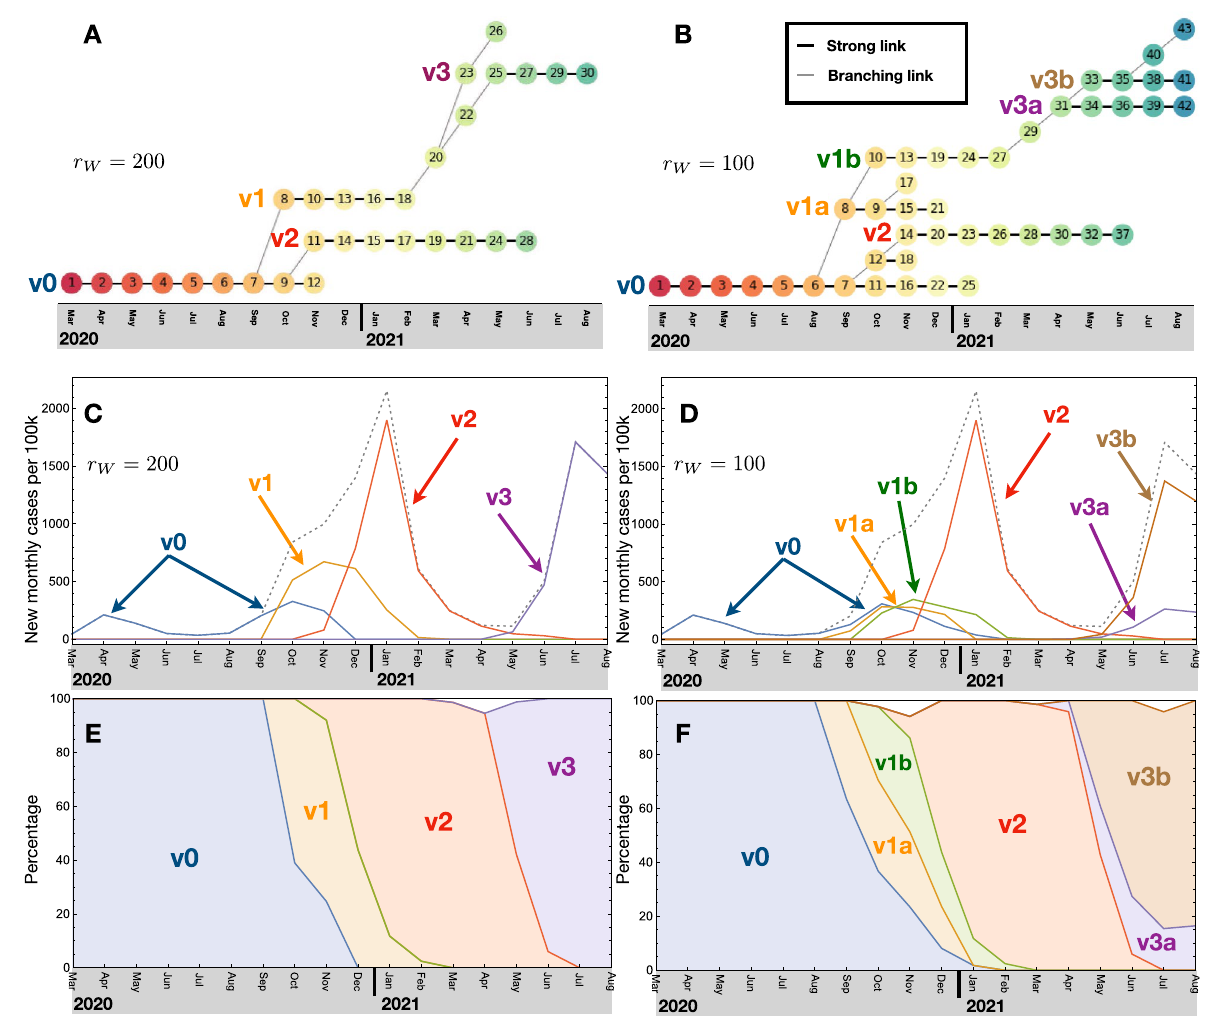
Figure 2. Monthly ML analysis and chain variants. The clusters are linked to form chains, which are then identified with emerging variants, as shown in the top plots ( A , B ). In the middle ( C , D ) and bottom ( E , F ) plots we show the number of monthly infected per 100k inhabitants and percentage of occurrence for each emerging variant. The shaded regions represent the relative percentage of the variants present at each time. The left plots ( A , C and E ) correspond to a cutoff in the Ward distance of r W = 200 while the right ones ( B , D and F ) to r W = 100 . Note that the chains v2 and v3 for r W = 200 can be associated to the Alpha and Delta VoC,